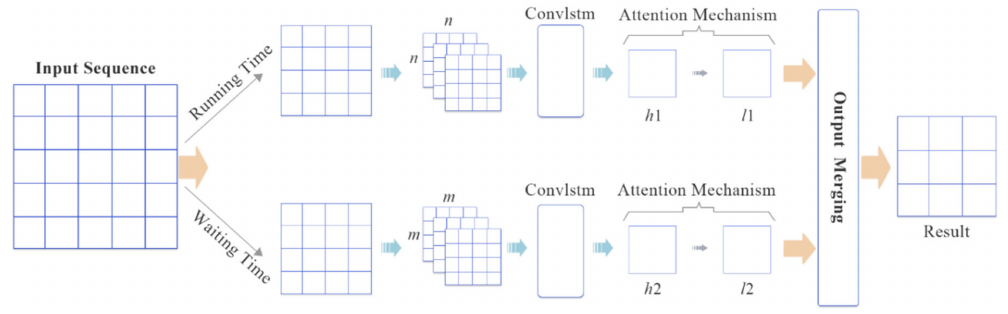
Figure 3. Self-attention-based ConvLSTM network.